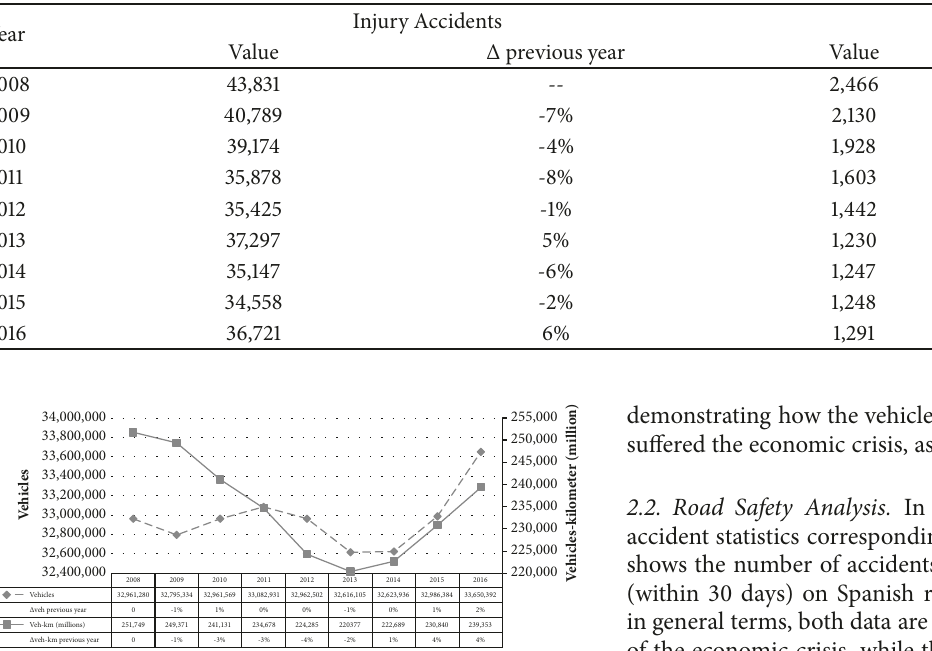
Table 2: Evolution of accidents [23–26].